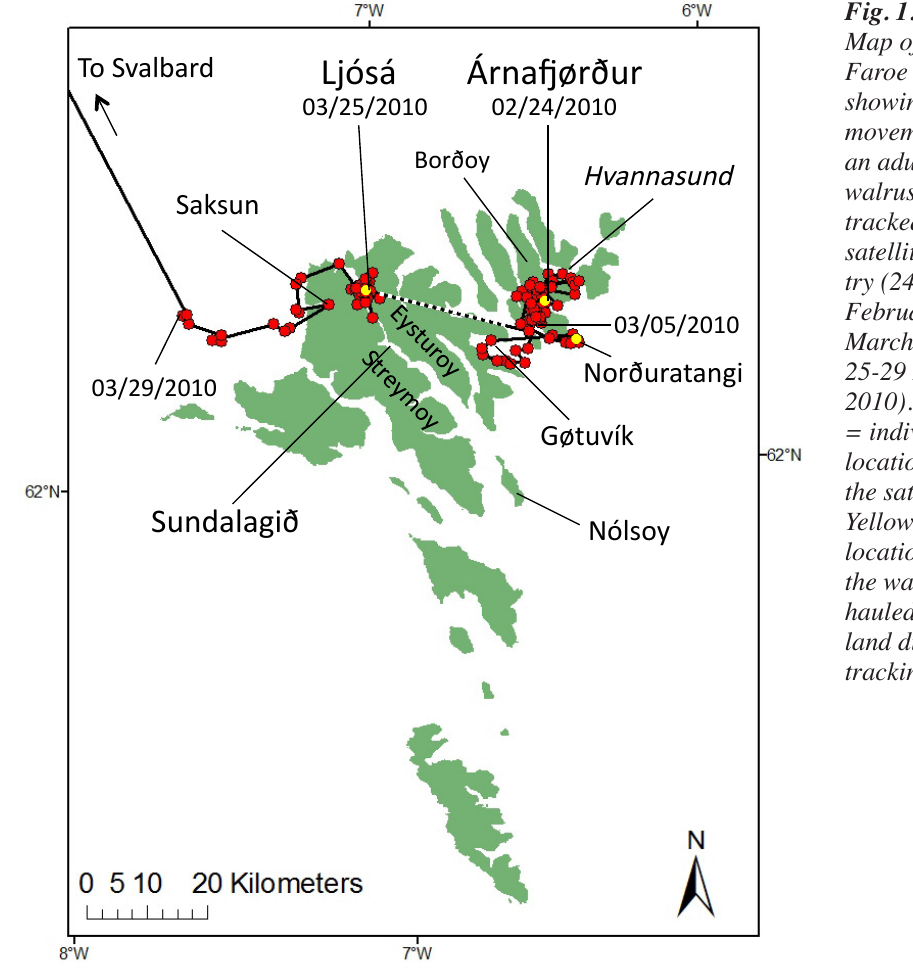
Map of the Faroe Islands showing the movement of an adult male walrus that was tracked using satellite-teleme- try (24 February – 5 March and 25-29 March 2010). Red dots = individual re- locations from the satellite tag. Yellow dots = locations where the walrus hauled out on land during the tracking